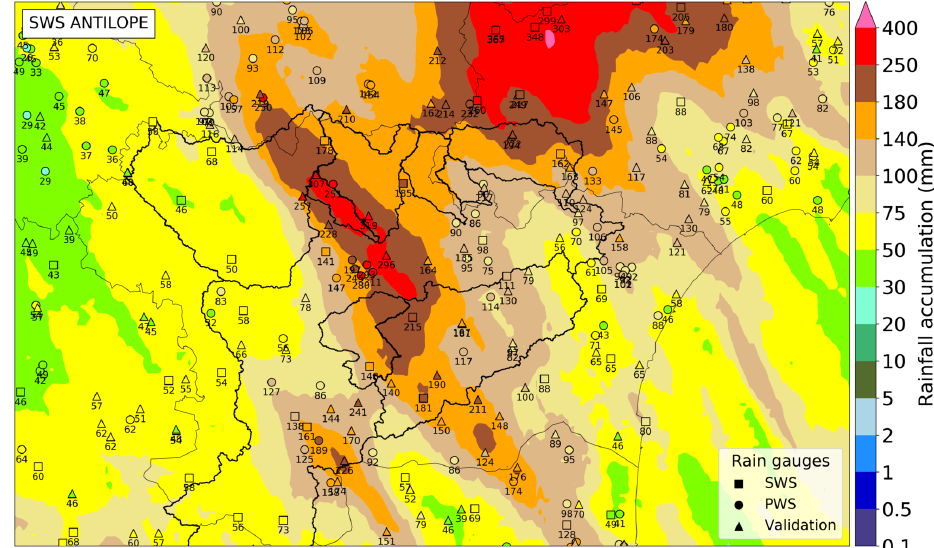
Figure A1. SWS ANTILOPE 48h rainfall accumulation superimposed with rain gauge accumulations (mm) between 06:00UTC on 14 Oc- tober and 06:00UTC on 16 October. Major river basins are indicated in bold black. The 48h period has been chosen to include manual Météo-France rain gauges to evaluate both products (in the “validation” group).